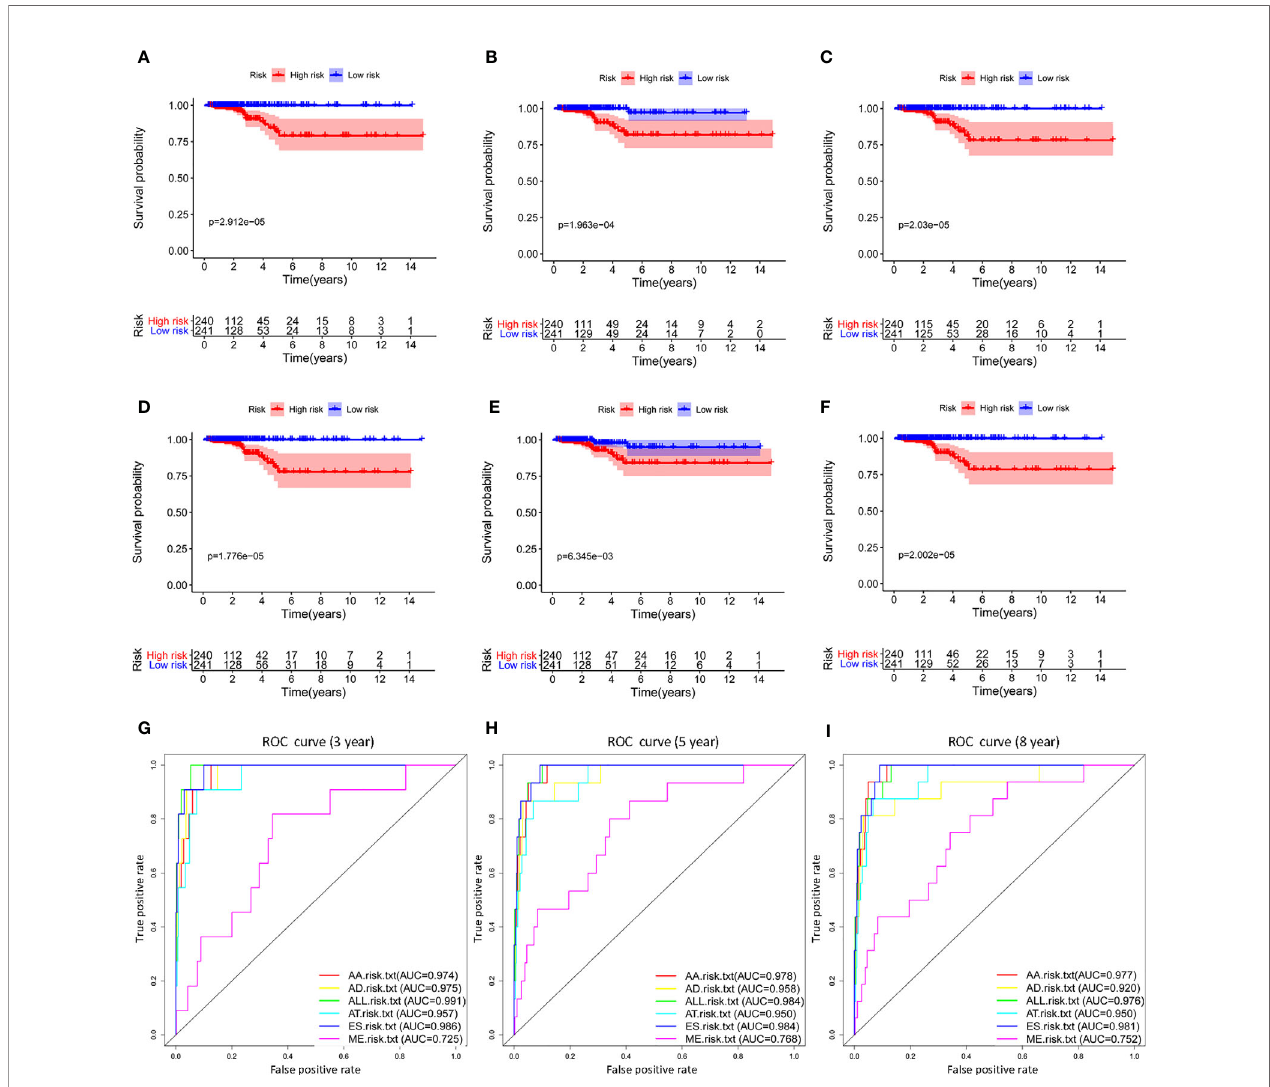
FIGURE 4 | The Kaplan – Meier curves analysis of overall survival between the low-risk patients and high-risk patients. AA cohort (A) , AD cohort (B) , AT cohort (C) , ES cohort (D) , ME cohort (E) , the fi nal prediction cohort (F) , (G – I) The 3, 5 and 8 year ROC curves of prognostic models based on individual type or all types of AS events in THCA. THCA, thyroid carcinoma; ROC, receiver operating